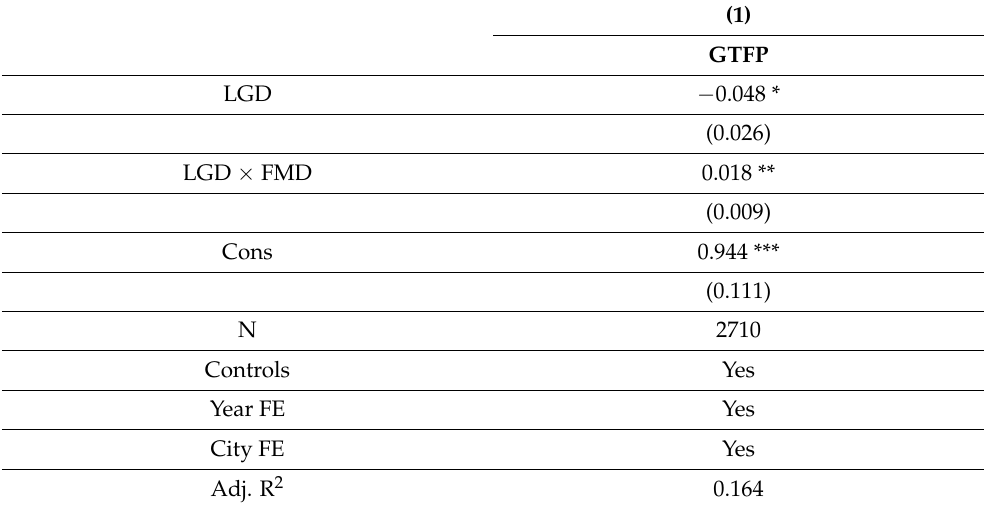
Table 6. Moderating effects